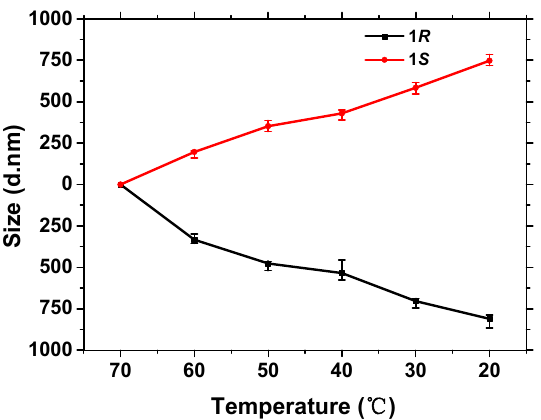
Figure 2. The dependence of the PAzoMA 1 aggregates’ size on the temperature, which is decreasing from 70 °C to 20 °C. These date are taken from Figure S4a,b. The concentration of polymer repeating units is the same as in Figure 1.